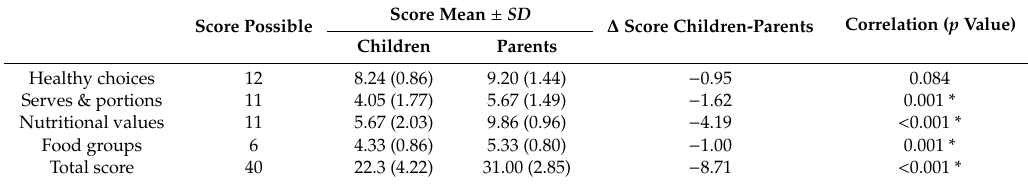
Table 3. Nutrition knowledge survey